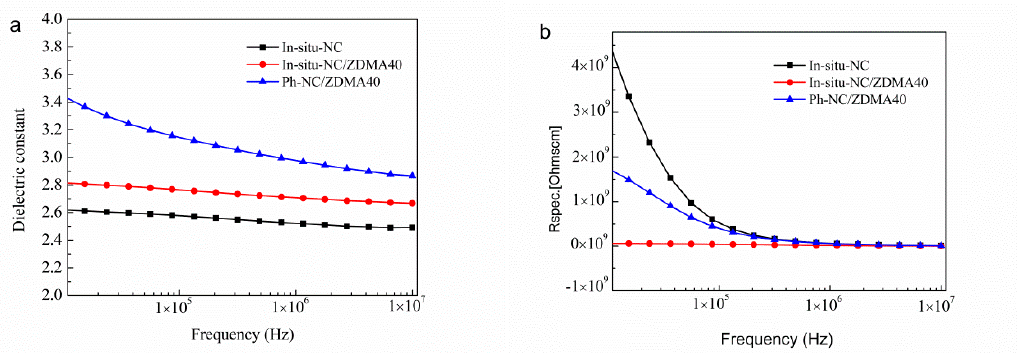
Figure 9. ( a ) Dielectric constant and ( b ) volume resistivity of in-situ-NC, in-situ-NC/ZDMA40, and ph-NC/ZDMA40 under the frequency sweeping mode.